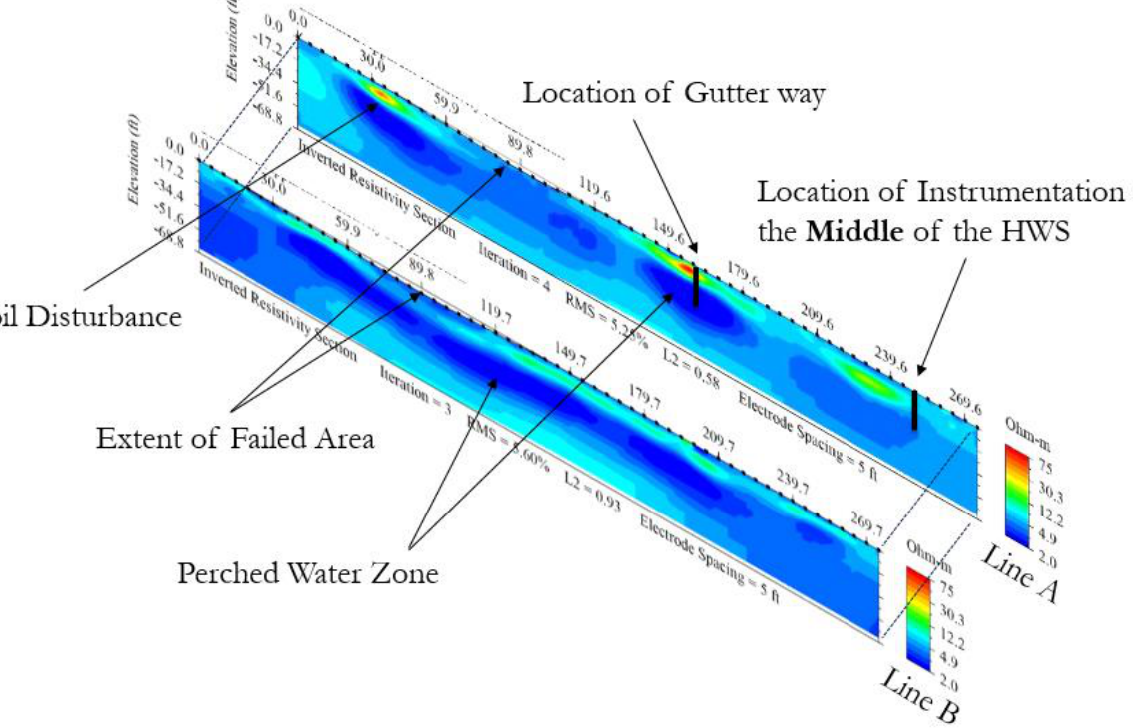
Figure 26. HWS 5, 2D ERI test profile at line A and at line B tested on 13 January 2021 (1 ft = 0.3 m).